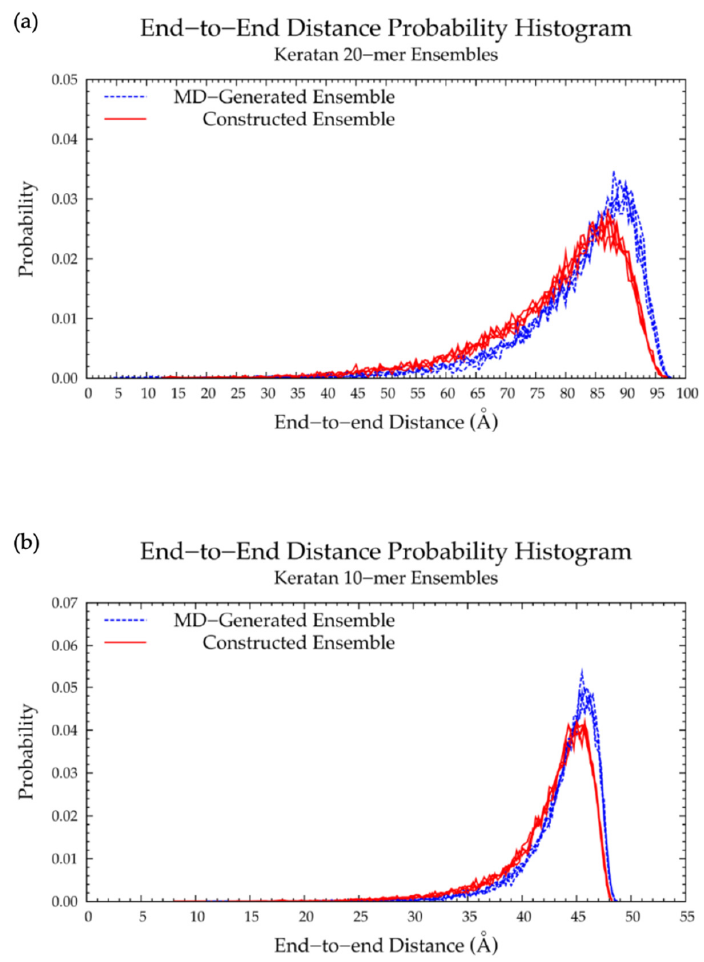
Figure 17. End-to-end distance probability distributions of MD-generated (blue dashed lines) and constructed (red solid lines) nonsulfated keratan ensembles: ( a ) 20-mer and ( b ) 10-mer; probabilities were calculated for end-to-end distances sorted into 0.5 Å bins for the 20-mer and 0.25 Å bins for the 10-mer; each ensemble includes four sets of 10,000 conformations.